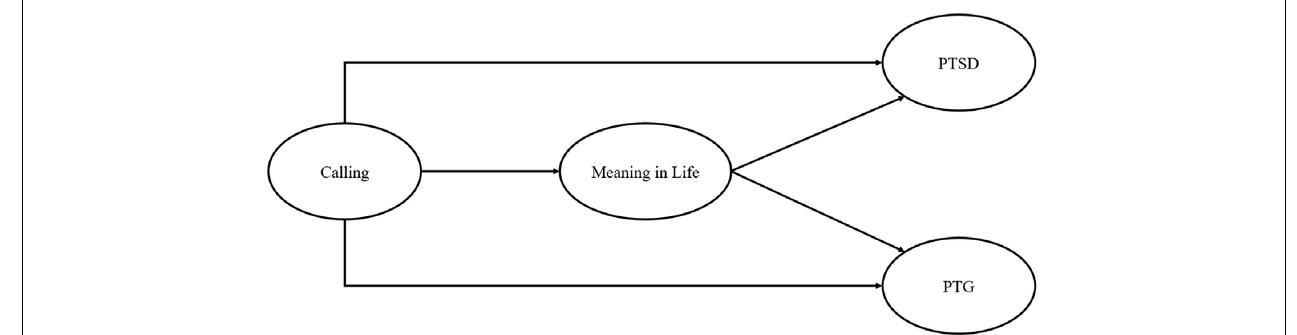
FIGURE 1 | Research